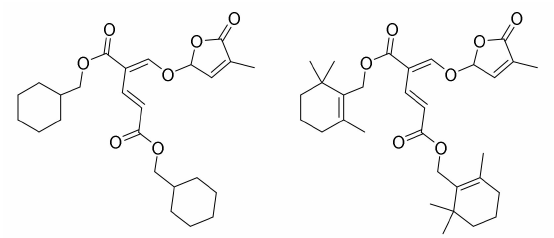
Figure 7. High active analogues of non-canonical strigolactones on Gigaspora margarita